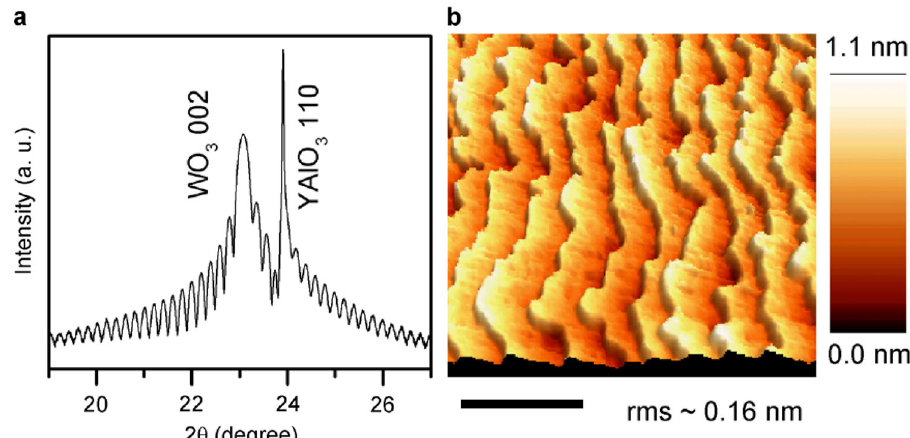
Fig. 1 Structural characterizations of WO 3 fi lms. a , High-resolution Cu K α θ − 2 θ X-ray diffraction (XRD) pattern of a 45 nm thick WO 3 fi lm deposited on a YAlO 3 (110) substrate. b , 3D atomic force microscope (AFM) image of a 14 nm thick WO 3 fi lm deposited on a YAlO 3 substrate. Scale bar is 200 nm. The root mean square (rms) roughness is only 0.16 nm and the step-like terraces indicate the fi lm has an atomically fl at